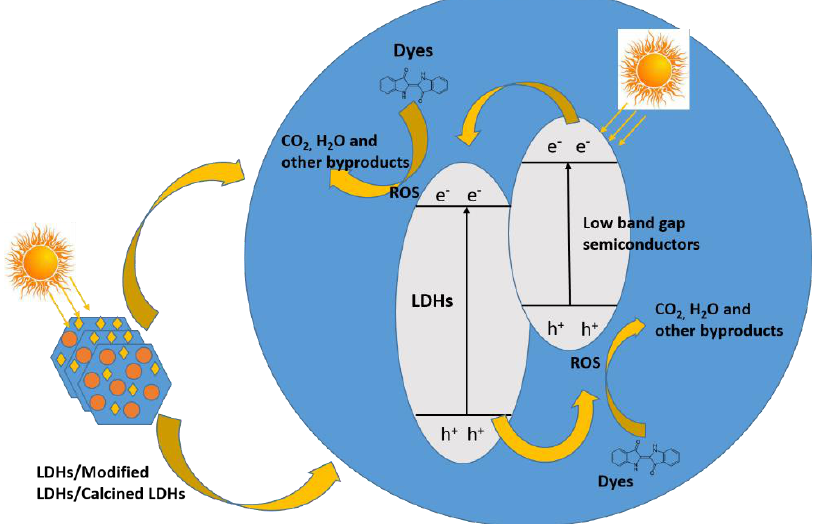
Figure 13. Schematic representation of photocatalytic degradation of dyes over LDH-based composite materials.